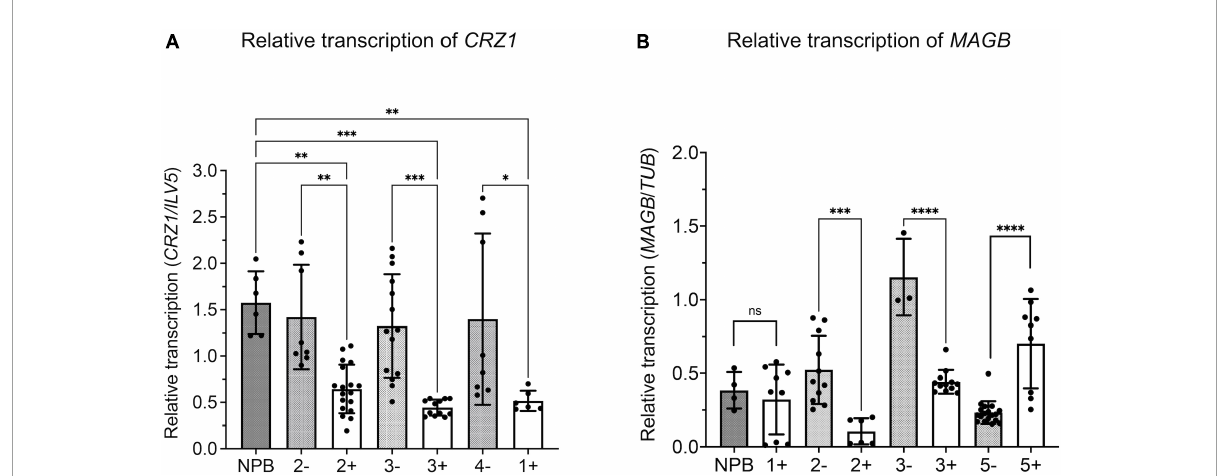
FIGURE7 Relative transcription of target gene reduced in Magnaporthe oryzae invading host-induced gene silencing (HIGS) transgenic rice targeting CRZ1 and MAGB . A,B Analysis of relative transcription of fungal gene CRZ1 (A) and MAGB (B) through quantitative RT-PCR. Fungal gene ILV5 (A) or β - Tubulin (B) were used as the reference gene. Multiple rice lines inoculated with M. oryzae were tested. “ + ” represents positive transgenic rice while “-” represents non-transgenic segregants. cDNA was generated from total RNA isolated from M. oryzae -inoculated rice leaves after 14 days. Bars represent mean values ± SDs of at least three independent sample collections. ( ∗ P < 0.0332, ∗∗ P < 0.0021, ∗∗∗ P < 0.0002, ∗∗∗∗ P < 0.0001; Tukey